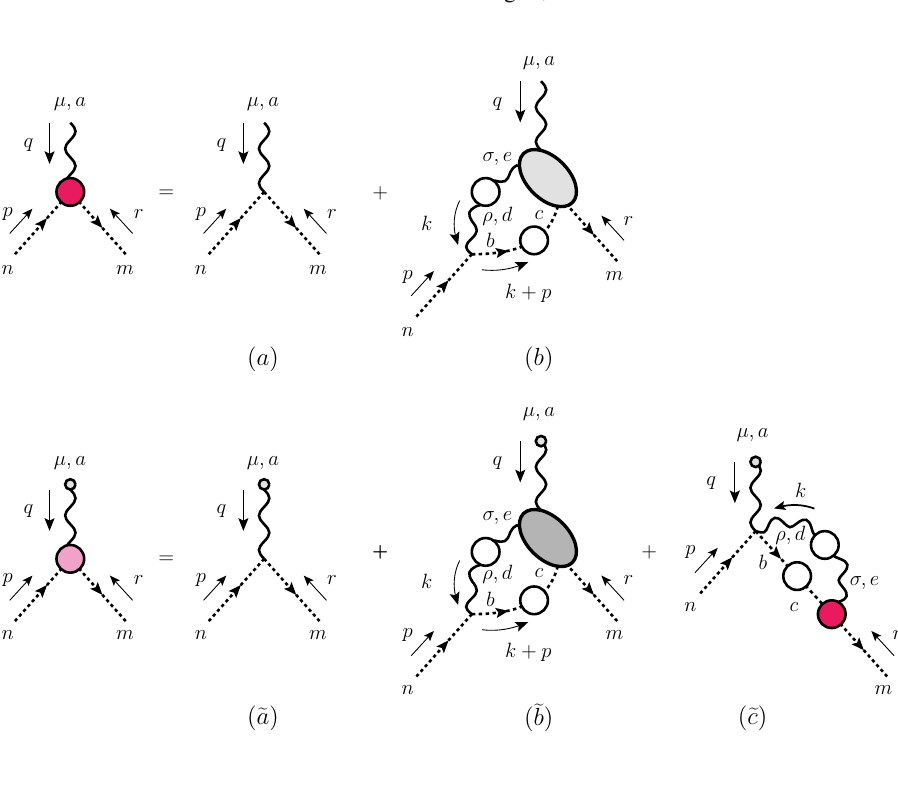
Fig. 1 The SDE satisfied by the gluon-ghost conventional (top) and BFM vertex (bottom). In this latter case an extra term ( (cid:2) c ) appears, due to the presence of the additional BFM tree-level coupling BQc ¯